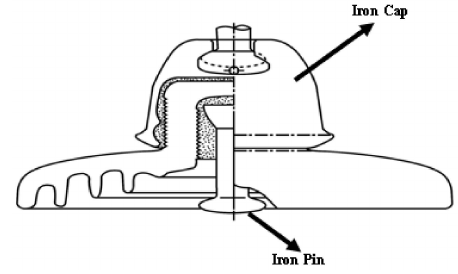
Figure 3. Cross-section of a porcelain